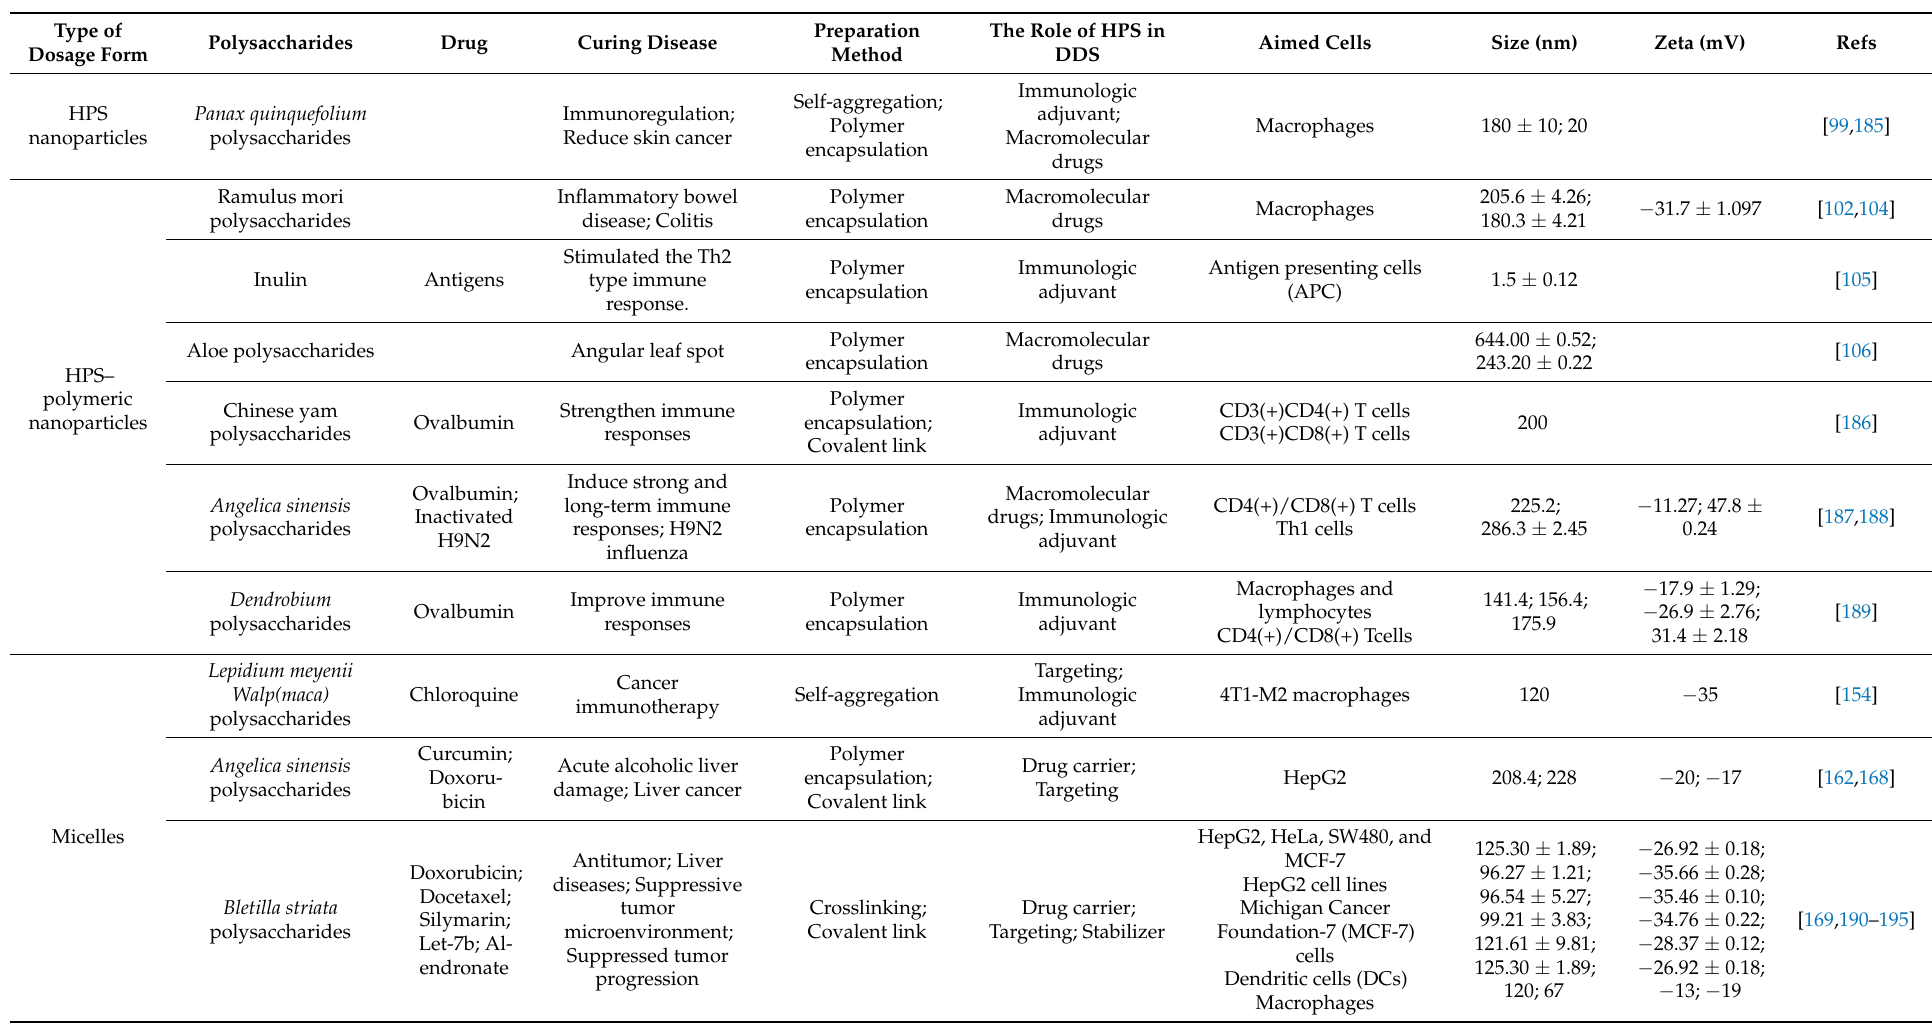
Table 2. Summary of